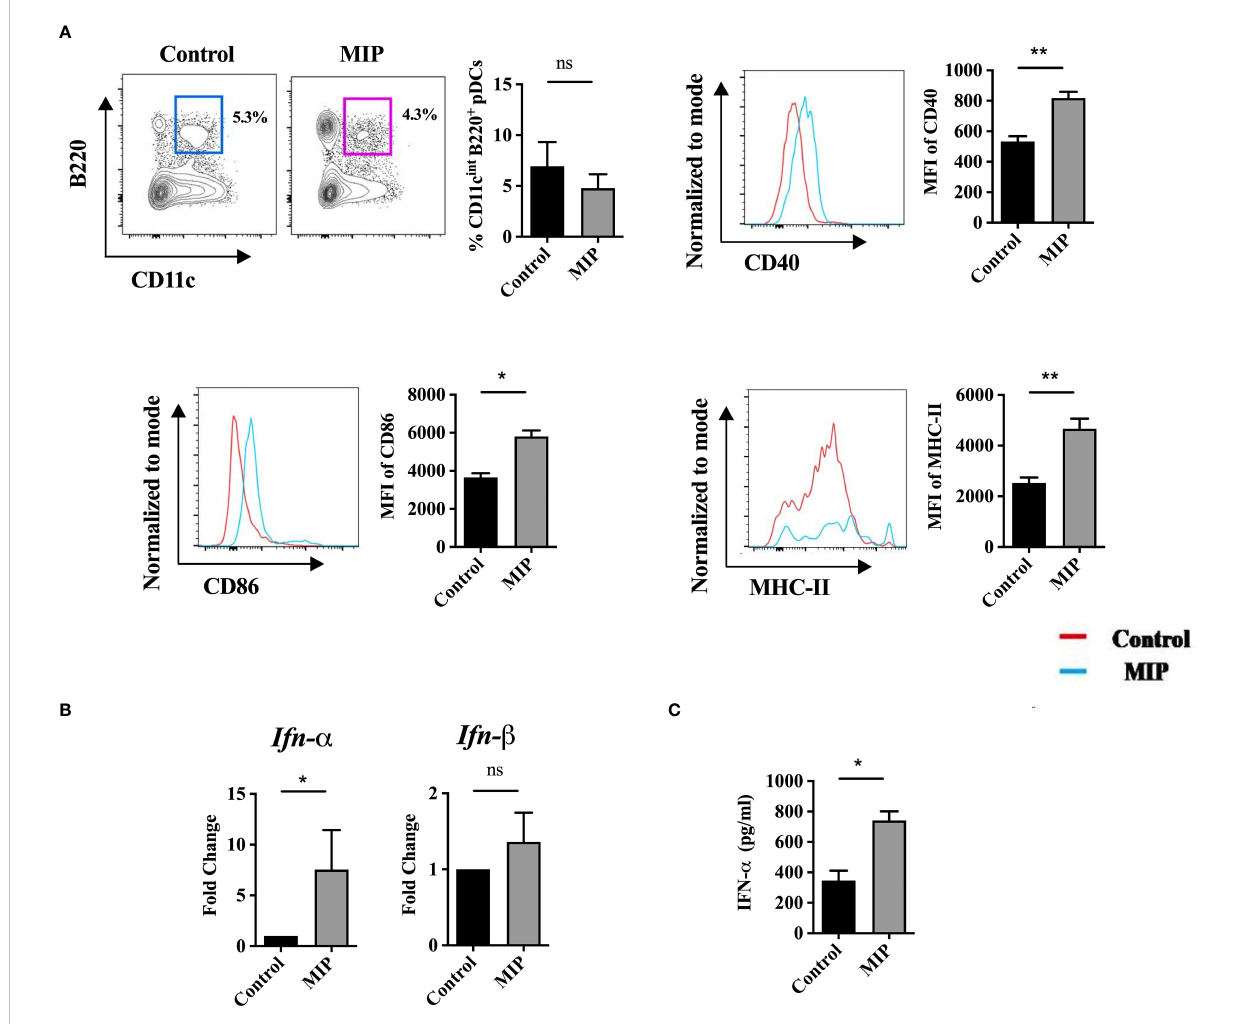
FIGURE 4 In fi ltration of pDCs in B16 tumors and effect of MIP treatment on their phenotype and function: (A) Flow cytometric analysis of in fi ltration, activation and maturation of tumor in fi ltrating pDCs (n=5). The contour plot is representative image of frequency of pDCs in one mouse per group. Representative histogram plots show MFI of each activation marker in one mouse per group. (B) mRNA expression of type 1 IFNs on total tumor in fi ltrating leukocytes (n=4). (C) 10 6 total leukocytes from tumor draining lymph node were seeded and cultured in complete RPMI for 48 hours in presence of B16 tumor lysate. Level of IFN- a from the supernatants was determined by ELISA (n=5). The results are expressed as mean ± SEM of one experiment. Statistical analysis was performed using unpaired Student ’ s t test (*:p<0.05, **:p<0.01, ns, non-signi fi cant). Two independent experimental repeats were